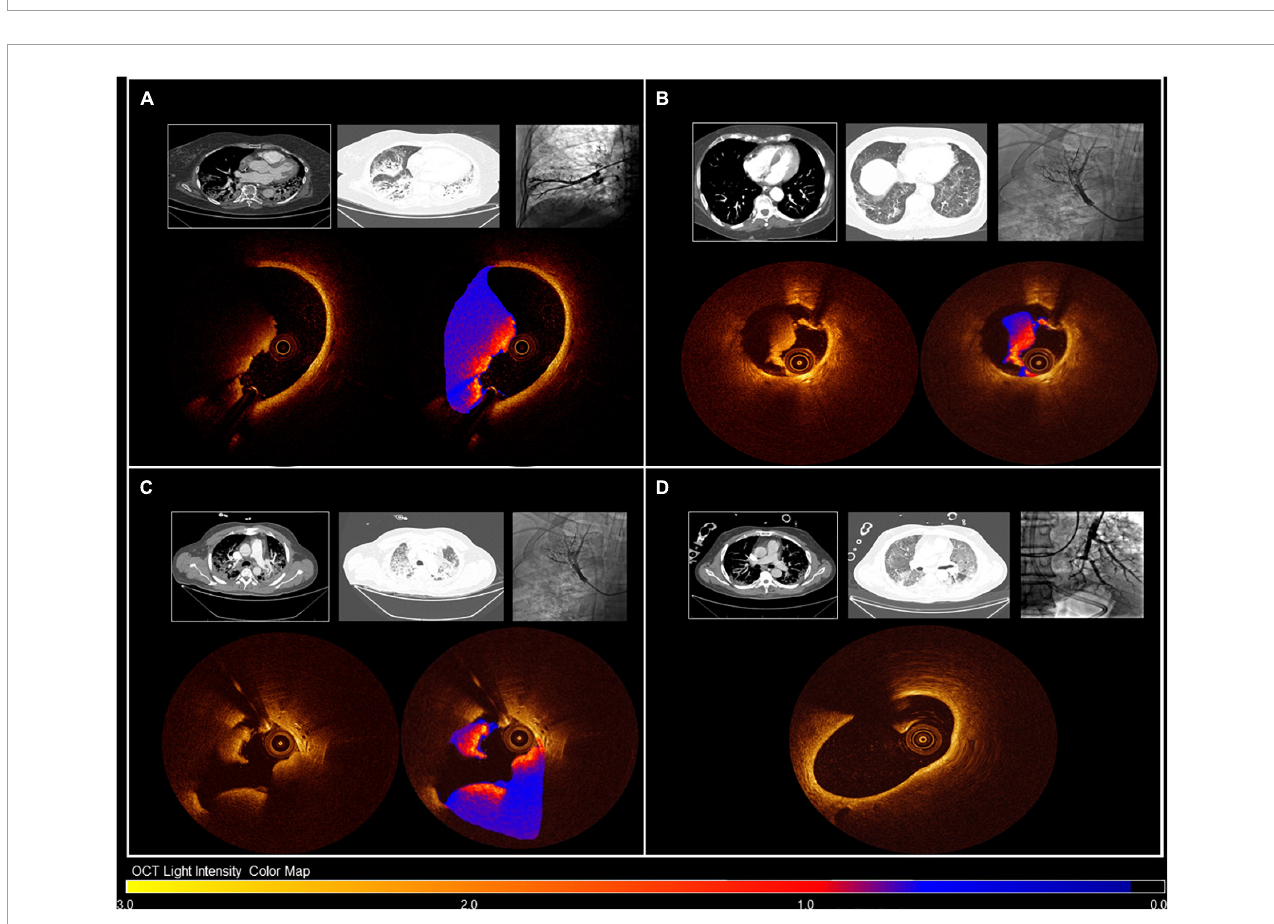
FIGURE2 OCT images of patients with distinct pulmonary microthrombosis presentation. Images are color-coded for OCT assessment of light intensity: darker colors indicate light attenuation, and lighter colors indicate areas of high light-intensity material. Panel (A) : Patient 4, Cohort B. CT scan was positive for pulmonary embolism. OCT confirmed distal pulmonary thrombosis with red thrombus. Panel (B) : Patient 3, Cohort A. CT scan was negative for pulmonary embolism. OCT showed distal pulmonary thrombosis with white thrombus. Panel (C) : Patient 2, Cohort B. CT scan was positive for pulmonary embolism. OCT confirmed distal pulmonary thrombosis with mixed thrombus. Panel (D) : Patient 1, Cohort A. CT scan was negative for pulmonary embolism. OCT did not show any distal pulmonary